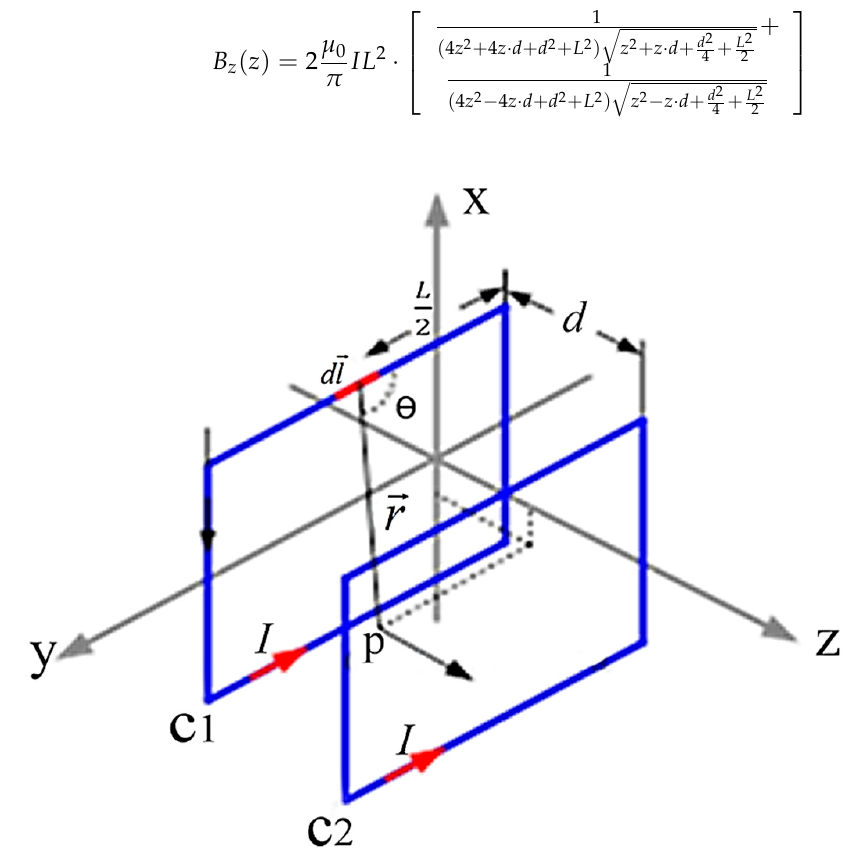
Figure 1. The square Helmholtz coil configuration.